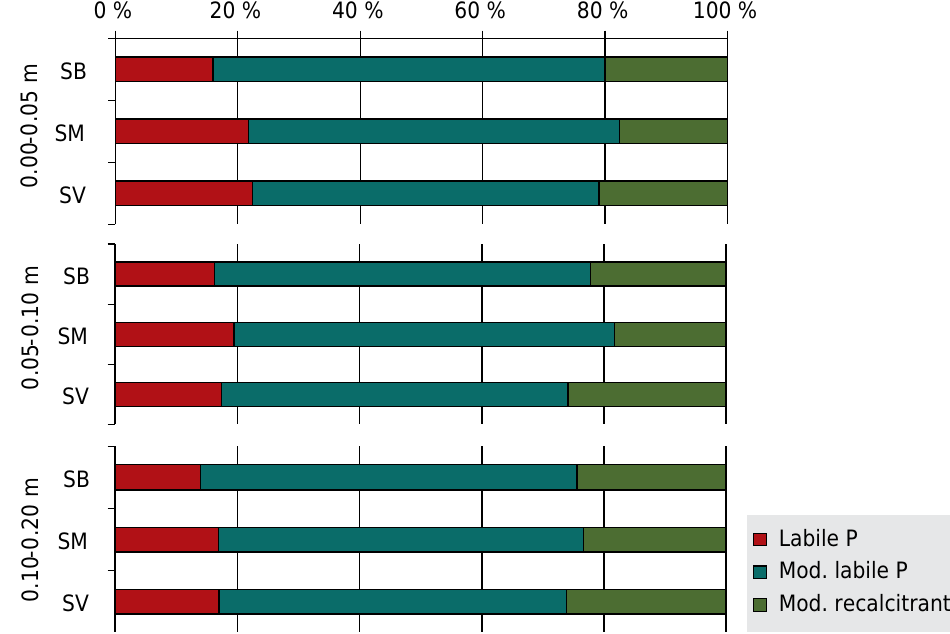
Figure 3. Percentage of labile, moderately labile and moderately recalcitrant phosphorus in the total phosphorus recovered, in slash-and-burn (SB), slash-and-mulch (SM) and secondary vegetation (SV) systems at different depths in an Argissolo Amarelo Distrófico